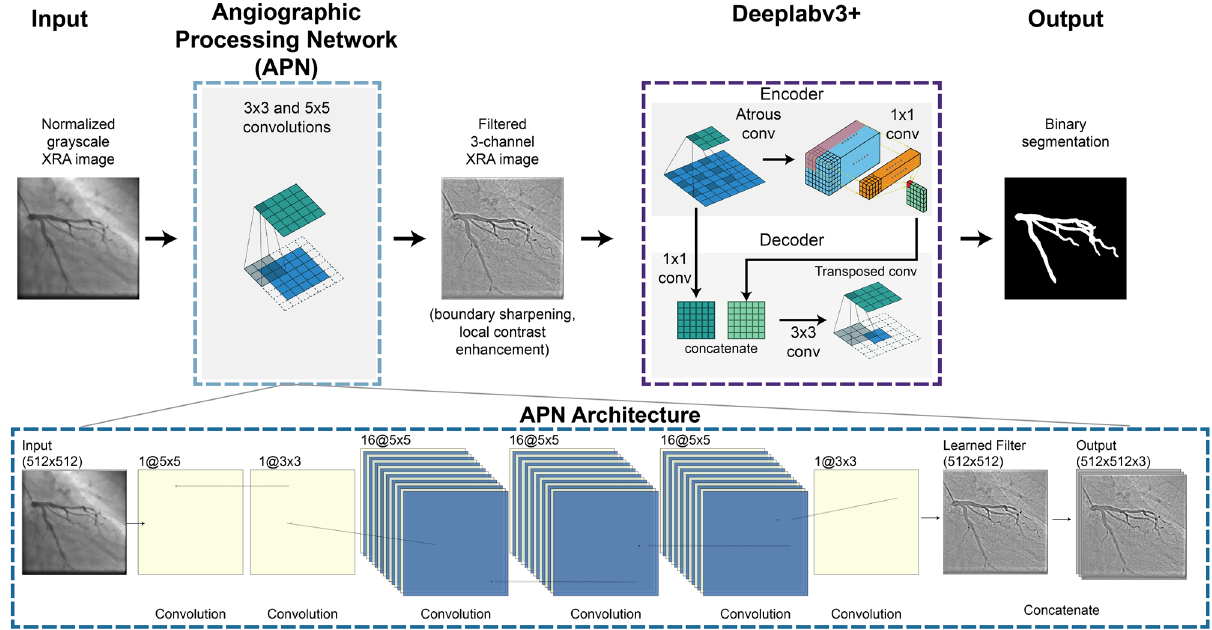
Figure 3. AngioNet Architecture Diagram. AngioNet is composed of an Angiographic Processing Network (APN) in tandem with Deeplabv3+. The APN is designed to improve local contrast and vessel boundary sharpness. The output of the APN, a single channel filtered image, is copied and concatenated to form a 3-channel image which is input into the backbone network.